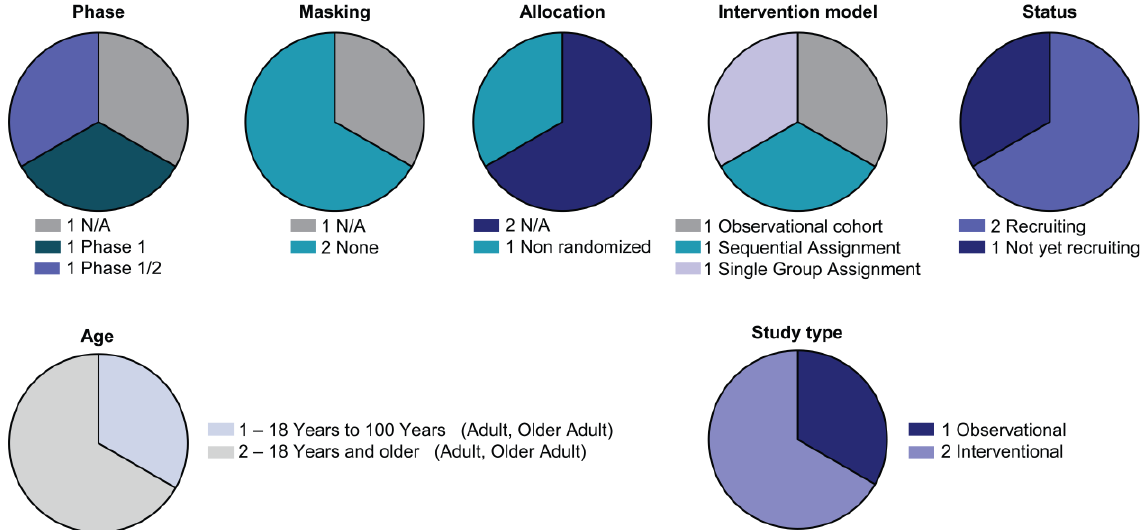
Figure 4. Detailed analysis of the CAR-M clinical landscape. Pie charts with categorisation of CAR- NK clinical trials by status and study design as indicated (phase, masking, allocation, intervention model assignment, status, age and study type).